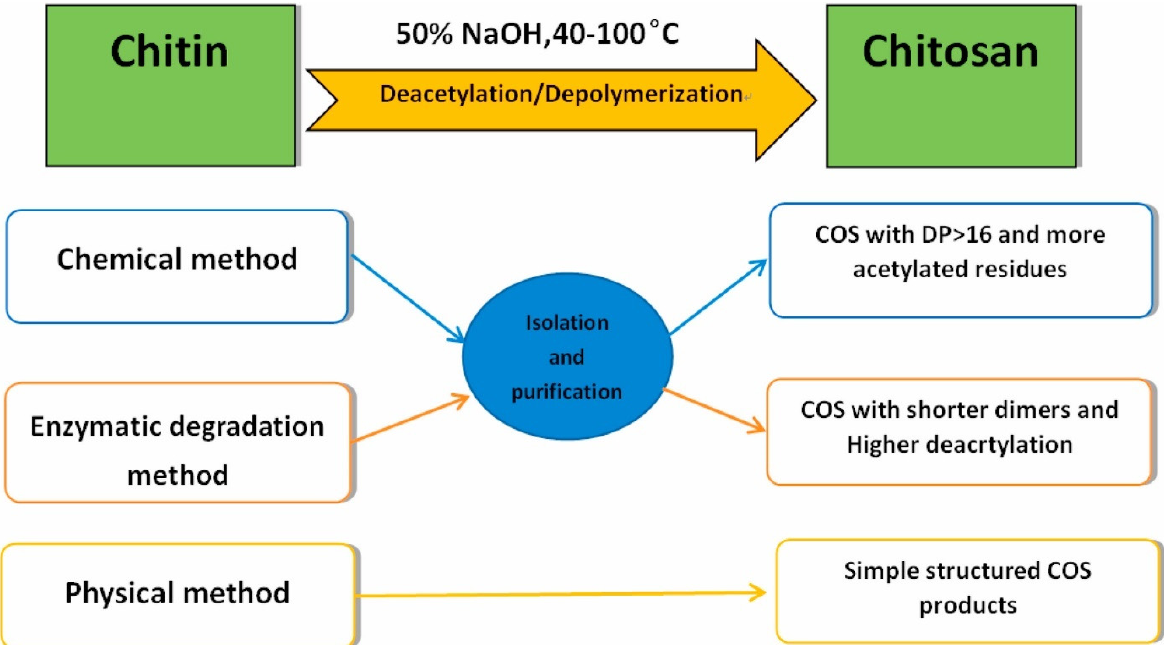
Figure 10. Preparation of COS from chitin and CS via physical, chemical, and enzymatic degradation methods [241]. Reproduced with permission from Elsevier (Copyright©2021).